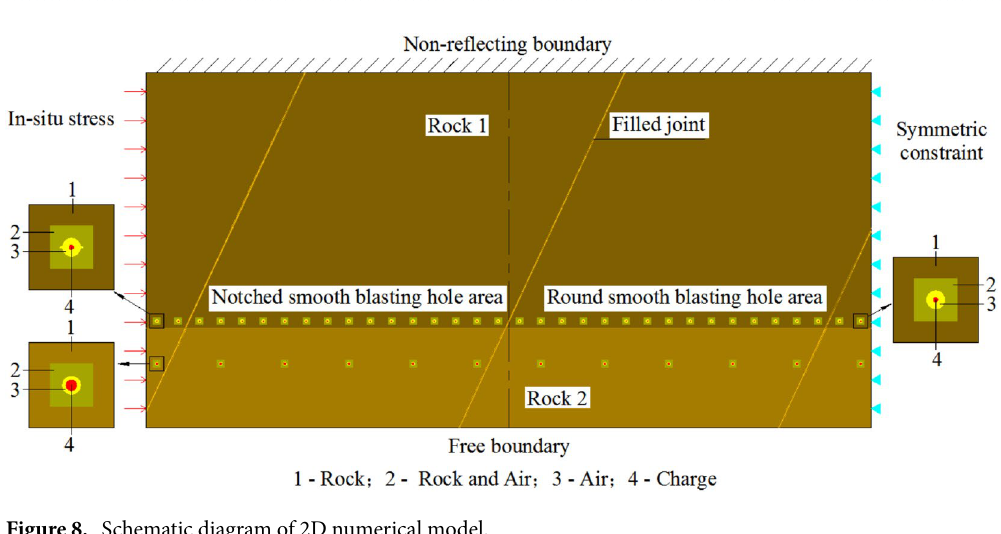
Figure 8. Schematic diagram of 2D numerical model.